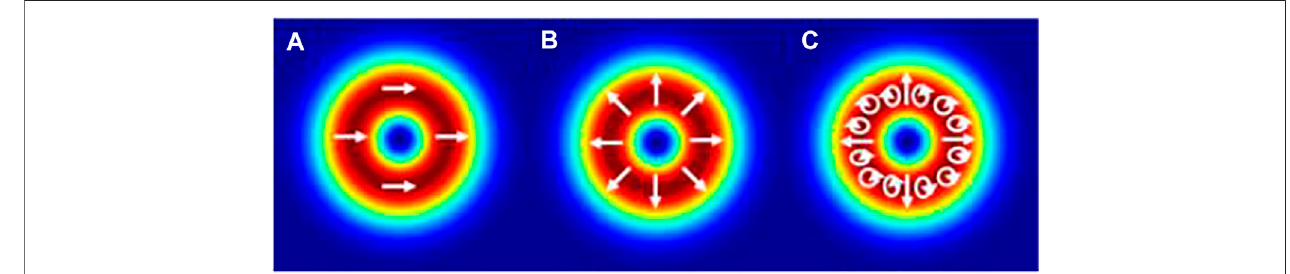
FIGURE 1 | Cross-section of the initial optical fi eld: (A) HGB, (B) RPB, and (C) AVHP.